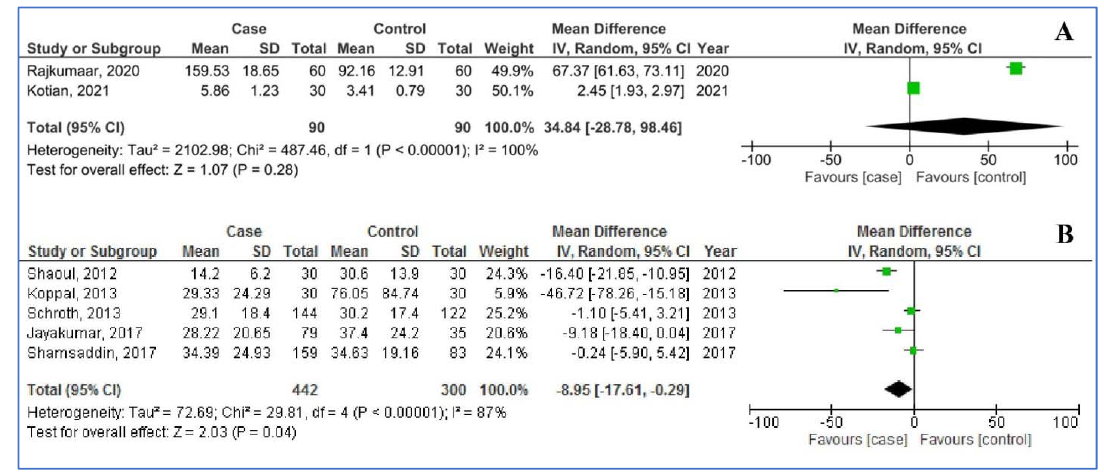
Figure 3. Pooled analysis of salivary ferritin ( A ) and serum ferritin ( B ) levels in the participants with dental caries (cases) compared to free caries (controls).